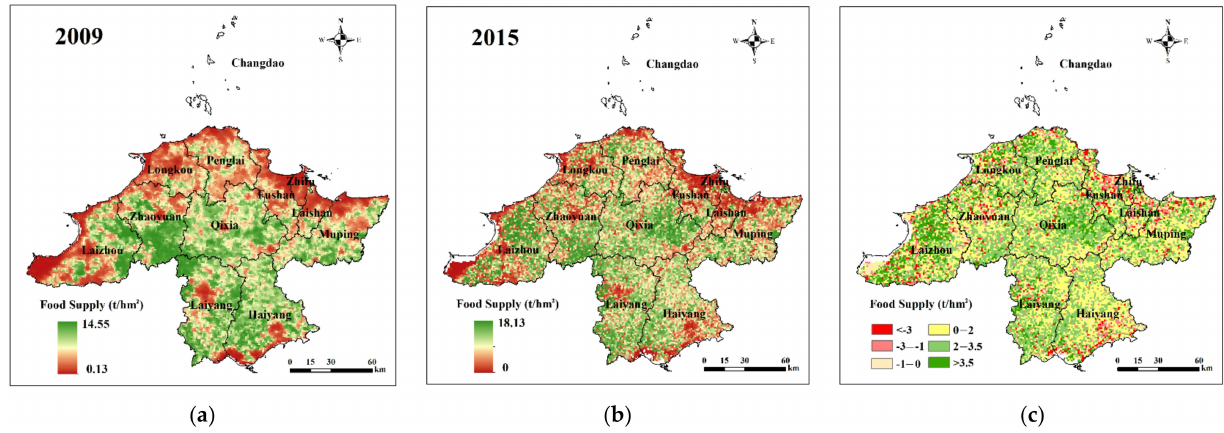
Figure 5. ( a ) Spatial distribution of food supply in Yantai in 2009; ( b ) spatial distribution of food supply in Yantai in 2015; ( c ) changes of food supply in Yantai from 2009 to